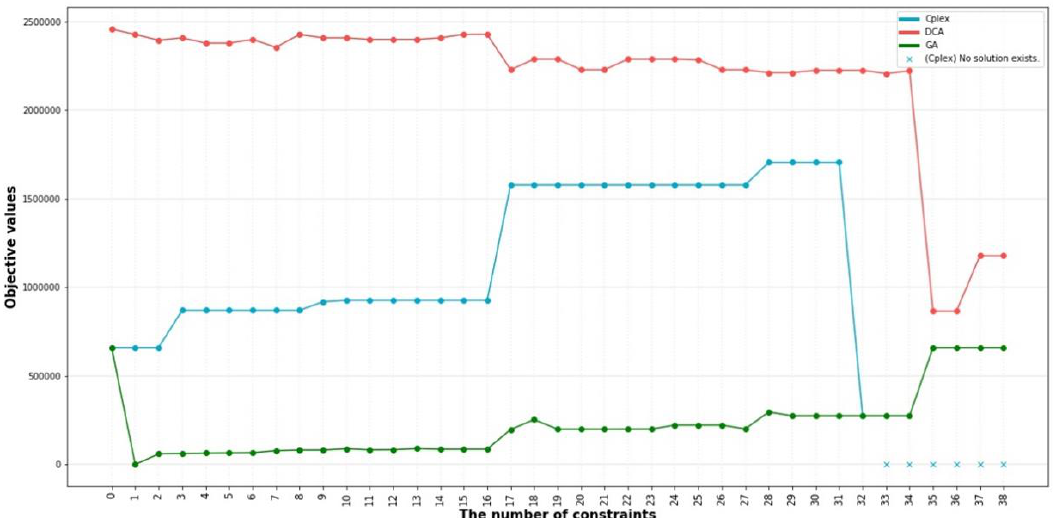
Figure 14. The objective values of the algorithms to find a team of three members from the top 2000 candidates.